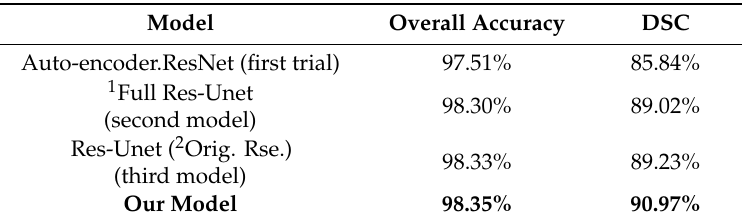
Table 4. Comparison of the